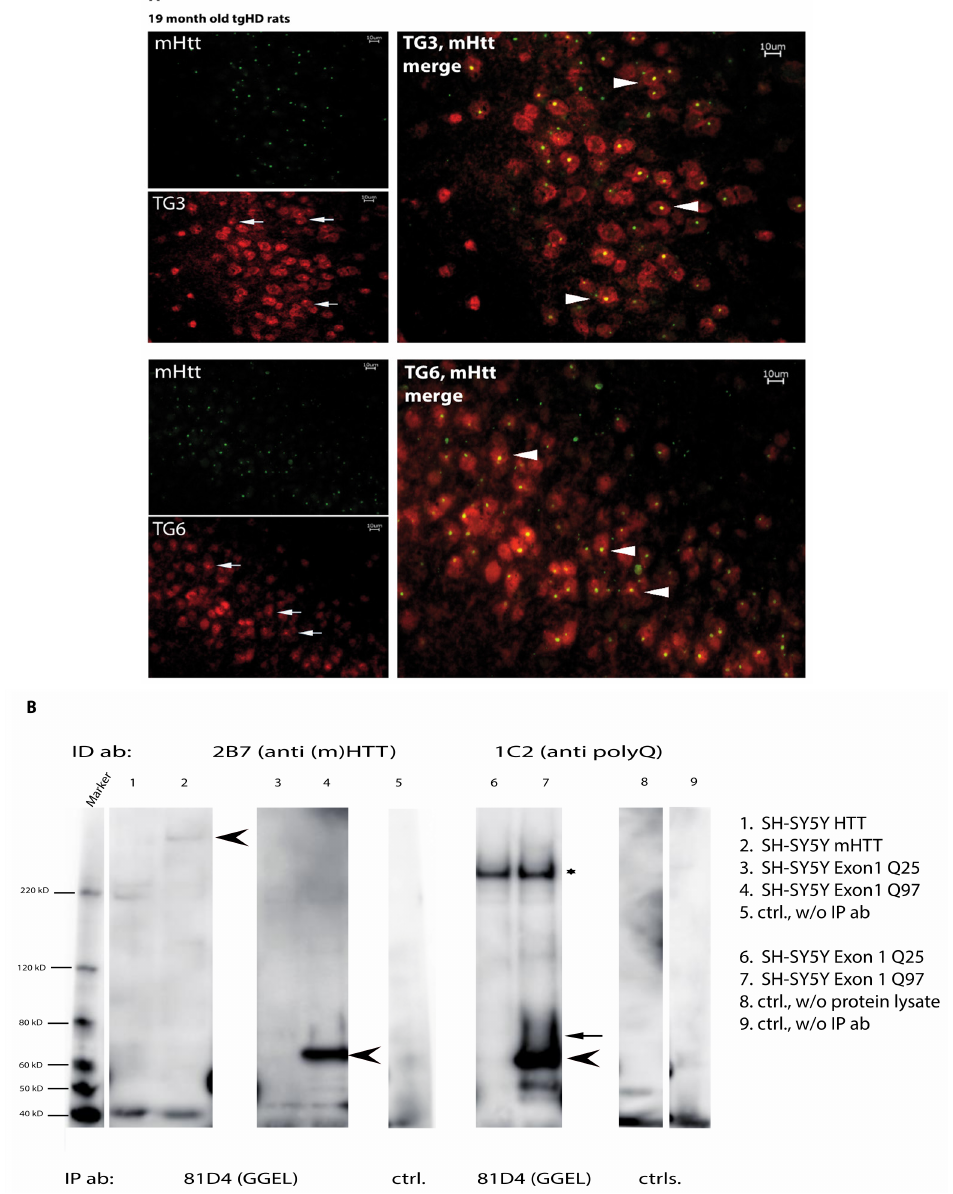
Figure 5. S830-immunopositive mHTT aggregates colocalize with transglutaminase isoforms and are positive for TG- enzymatic reaction products. ( A ) Immunolabeling of brain sections from tgHD rats with the S830 antibody revealed a pronounced and punctuate staining, particularly in the piriform cortex and the olfactory tubercle of HD transgenic rats. Some cells in these areas also showed a colocalized intracellular staining signal with TG isoform 3 and 6 (arrows) and mHTT, as detected with the antibody S830 (arrowheads). Scale bars: 10 µ m. ( B ) mHTT protein and exon 1 Q97 fragment are positive for N- ε -( γ -L-glutamyl)-L-lysine (GGE L) bonds. Immunoprecipitation of GGEL-modified (m)HTT proteins and exon 1 fragments by the 81D4-antibody in total protein lysates of transfected SH-SY5Y cells. Blots displayed specific differences regarding the presence of GGEL-modified mutated full-length huntingtin or exon 1 Q97 as detected by the HTT-specific antibody 2B7 (CHDI) (1:2000) or an antibody directed against a prolonged polyglutamine stretch (1C2, MerckMillipore Darmstadt) (1:1000). Arrow and arrowheads indicate either full-length mutated huntingtin (about 350 kDa) or exon 1 Q97 (about 70 kDa), asterisk indicates unspecific signal using Protein L Agarose (Santa Cruz Biotechnology, Heidelberg, Germany) for